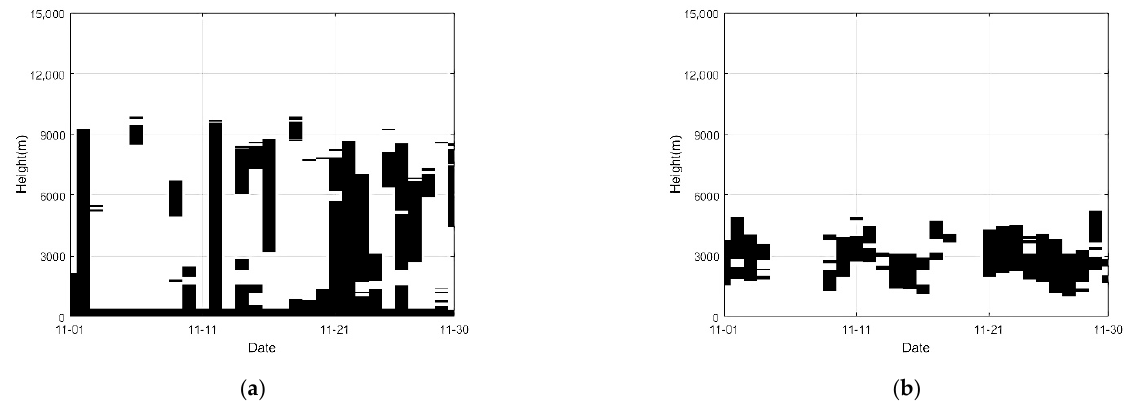
Figure 5. Comparison of millimeter-wave radar data and radiosonde Data in November 2003. ( a ) Galileo Radar; ( b ) Sound- ing.